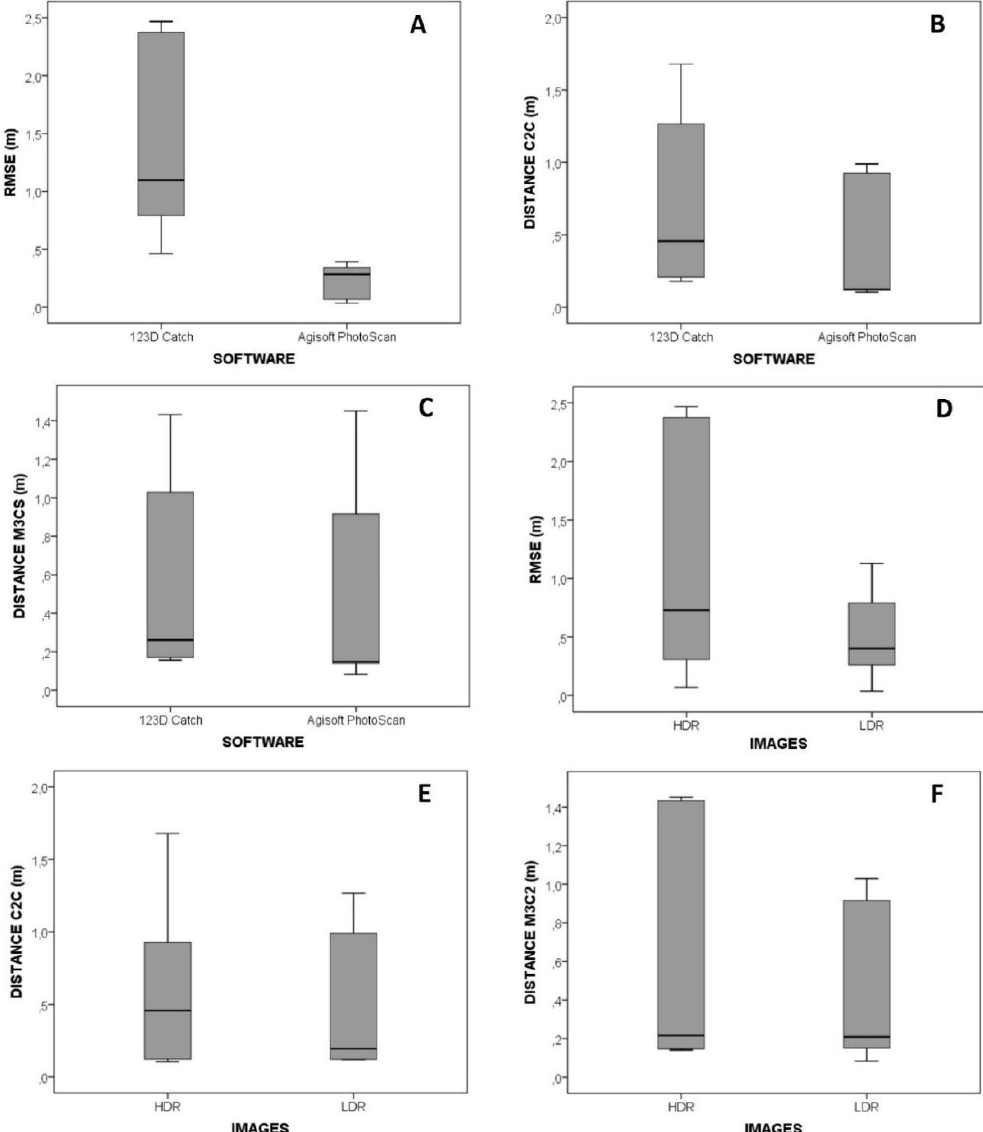
Figure 9. Box plot diagrams showing the ( A ) Root Mean Square Errors (RMSE) obtained during the referencing procedure and grouped by the software used for the photo- reconstruction ( B ) absolute average distance from the point clouds to the benchmark model estimated by the Cloud to Cloud (C2C) method and grouped by the software used for the photo-reconstruction, ( C ) Absolute average distance from the point clouds to the benchmark model estimated by the Multiscale Model to Model (M3C2) method and grouped by the software used for the photo-reconstruction, ( D ) RMSE obtained during the referencing procedure and grouped by the type of images used in the photo-reconstruction, ( E ) absolute average distance from the point clouds to the benchmark model estimated by the C2C method and grouped by the type of images used in the photo-reconstruction, and ( F ) absolute average distance from the point clouds to the benchmark model estimated by the M3C2 method and grouped by the type of images used in the photo-reconstruction. Note that box plot diagrams show the maximum and the minimum values using the whiskers (upper and lower respectively), the interquartile range (the box) and the median (the line within the